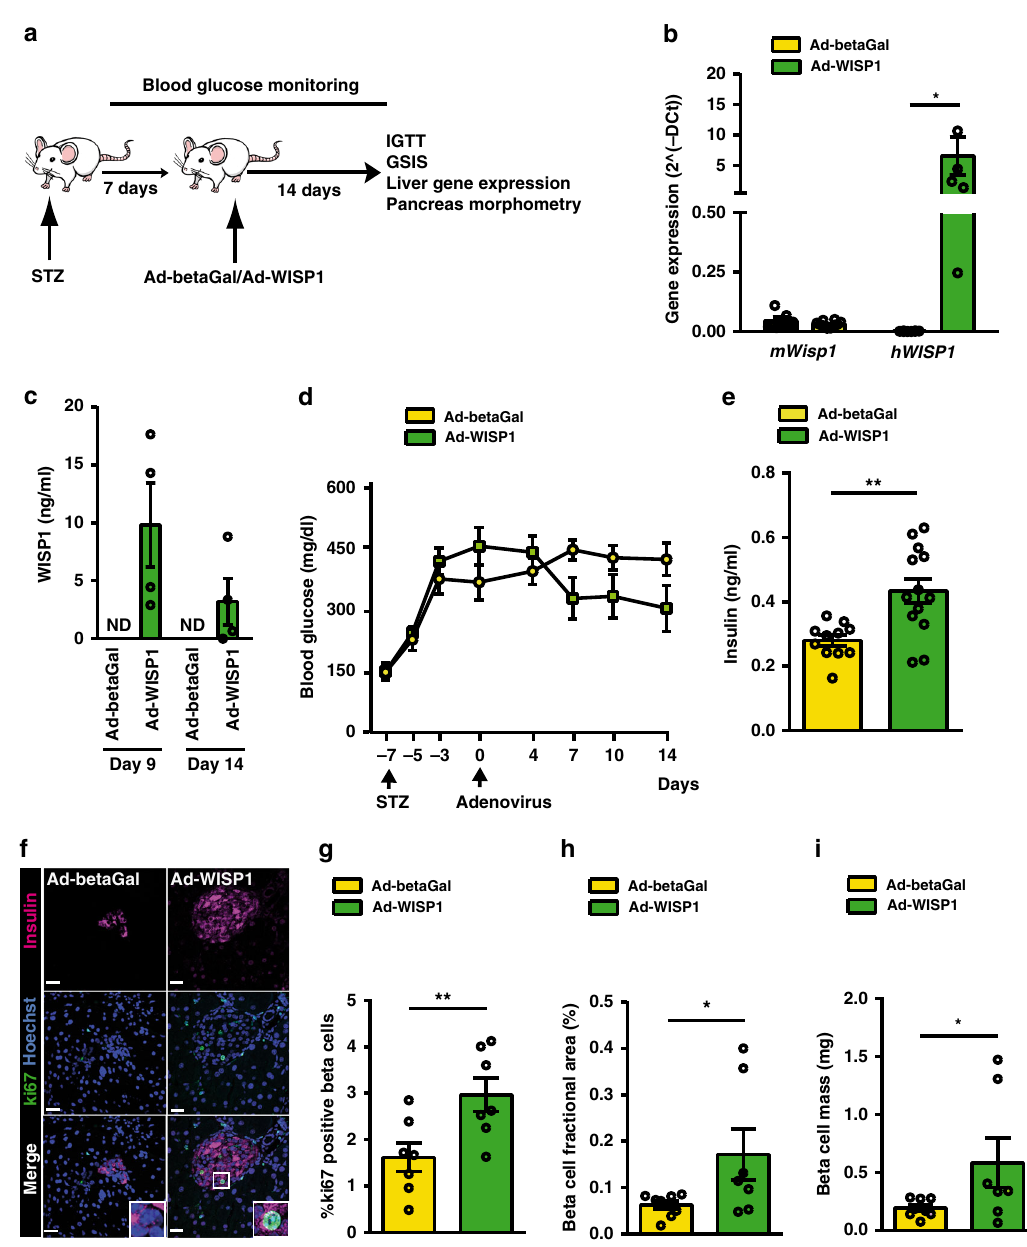
Fig. 5 Adenovirus-mediated expression of Wisp1 promotes endogenous beta cell proliferation in adult diabetic mice. a Schematic of experimental plan. b Quanti fi cation by qPCR of mouse Wisp1 mRNA ( n = 6 for Ad-betaGal, yellow; n = 10 for Ad-WISP1, green) and human WISP1 transcripts ( n = 8 for Ad- betaGal, yellow; n = 6 for Ad-WISP1, green) in the livers of mice fourteen days post-injection. Expression levels are expressed relative to Tbp . c Serum human WISP1 levels were measured by ELISA at days 9 and 14 post-injection with Ad-betaGal ( n = 5) or Ad-WISP1 ( n = 4, green). Human WISP1 was not detectable (ND) in mice injected with Ad-betaGal. d Blood glucose concentrations measured at the indicated days post-injection with Ad-betaGal ( n = 8, yellow) or Ad-WISP1 ( n = 7, green). e Serum insulin at day 14 following administration of Ad-betaGal ( n = 11, yellow) or Ad-WISP1 ( n = 13, green). f , g Beta cell proliferation following injection of Ad-WISP1 and Ad-betaGal. f Representative images of immuno fl uorescence staining against ki67 (green) and insulin (purple) in fi xed pancreases at day 14 after injection of the indicated adenoviruses. Nuclei are labeled with Hoechst (blue). g Percentage of beta cells (insulin + ) that are ki67 + at day 14 days after injection of the indicated adenoviruses ( n = 7; Ad-betaGal in yellow, Ad-WISP1 in green). h Beta cell fractional area (insulin + area relative to total pancreatic area) and i total beta cell mass at day 14 after injection of Ad-betaGal ( n = 8, yellow) or Ad-WISP1 ( n = 7, green). All data shown represent mean ± SEM for the indicated n . * p < 0.05; ** p < 0.01 using two-tailed Student ’ s t test ( b , e) , one-tailed Student ’ s t test ( g – i ) and two-way ANOVA ( d ). Scale bars are 25 μ the liver 14 days post-injection with Ad-WISP1 without hyperglycemia during the follow-up period, even though there accompanying changes in endogenous Wisp1 transcripts (Fig. 5b). was a trend to lower glucose levels (Fig. 5d). However, at day 14 The presence of human WISP1 in serum of Ad-WISP1 injected after injection with Ad-WISP1, mice exhibited a signi fi cant mice was con fi rmed at days 9 and 14 post-viral injection (Fig. 5c). increase in ad lib fed plasma insulin levels as compared to animals Systemic overexpression of WISP1 did not normalize Stz-induced injected with Ad-betaGal (Fig. 5e). This change was not